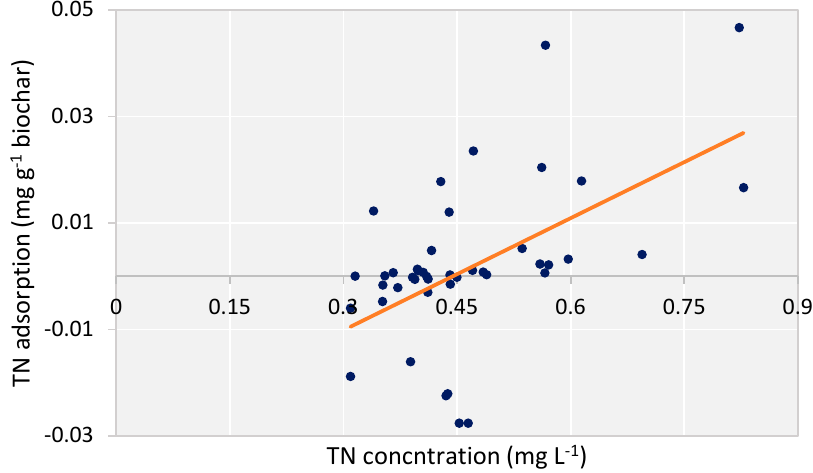
Figure 3. Total nitrogen (TN) adsorption as a function of water TN concentration in biochar reactor.